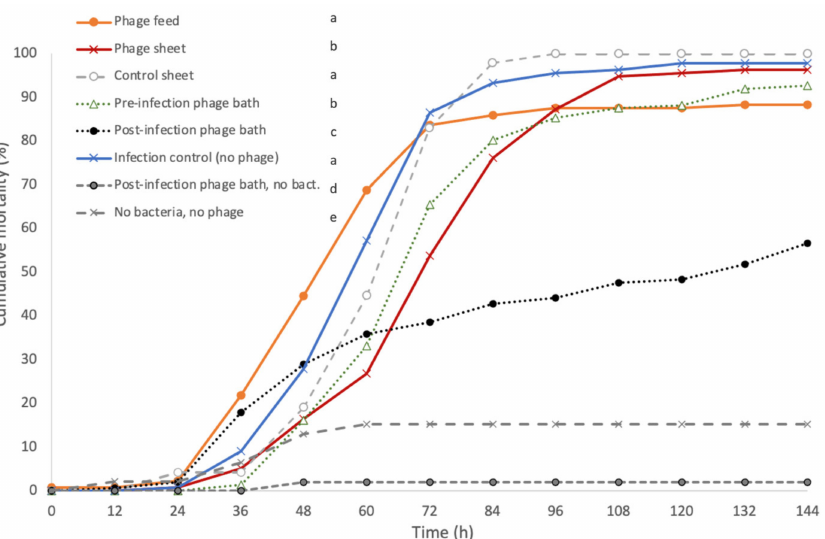
Figure 4. Experiment III: Cumulative mortalities (%) of rainbow trout fry infected with a mix of Flavobacterium columnare isolates FCO-F2 and B185. Rainbow trout were kept in three replicate aquaria per treatment (48 fish each) except for controls, which included only a single aquarium (total n of fish in experiment = 960). The fish were fed 7 days before the infection with phage mix-coated (FCOV-F27 and FCL-2) feed (phage feed), kept with the phage mix-coated sheet (phage sheet), or a control sheet without phage mix (control sheet) during the whole experiment starting from 7 days before bacterial infection, or treated with a 2-h phage mix bath one day before bacterial infection (pre-infection phage bath) and right after the first symptoms of columnaris disease appeared after the bacterial infection (post-infection phage bath). Negative controls for pre-infection phage bath and phage feed did not cause any mortality and are not shown in the graph. Different lower-case letters indicate statistical difference ( p < 0.05, Kaplan–Meier survival analysis, log rank pairwise comparisons, Mantel–Cox) between the treatment